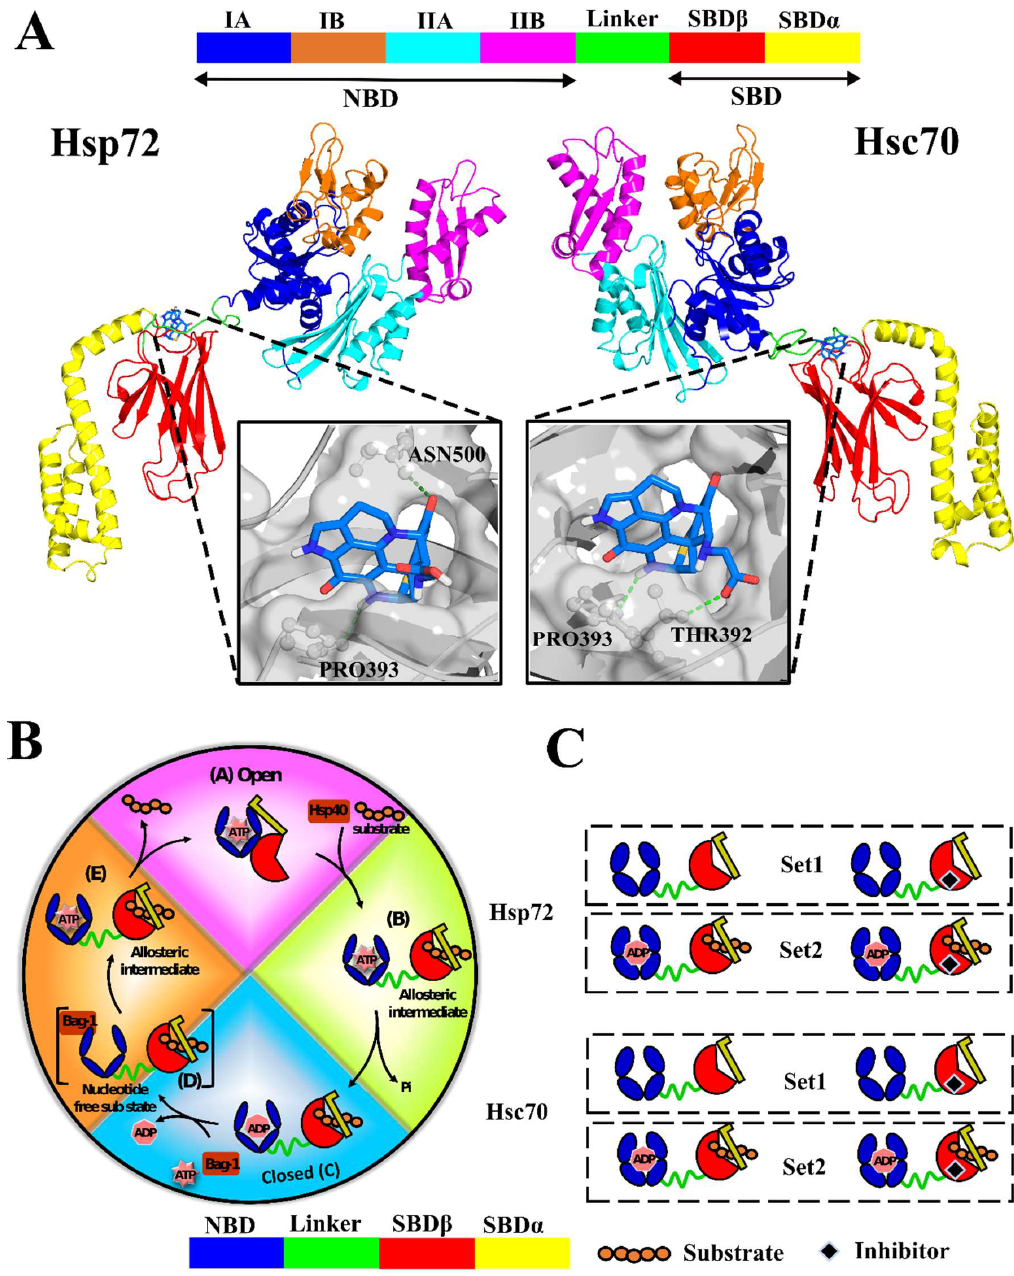
Figure 1. ( A ) Cartoon representation of Hsp72 and Hsc70 3D structures calculated via homology modelling. The nearly full-length closed confirmation structures of Hsp72 and Hsc70 were modelled from Escherichia coli DnaK PDB entry: 2KHO. Predicted binding mode of SANC00132 docked to the allosteric target site, the SBDβ back pocket, is shown in sticks. Polar contacts are displayed as green dashes while interacting residues are shown in ball and stick. ( B ) Canonical nucleotide dependent cycle of Hsp70. ( C ) Schematic illustration of the experimental approach. Set1 comprises the simulation of SANC00132-free and SANC00132-bound systems only. Set2 simulations are for SANC00132-free and SANC00132-bound systems complexed with endogenous modulators (ADP and peptide substrate). Concisely, each protein was subjected to both sets of experiments.